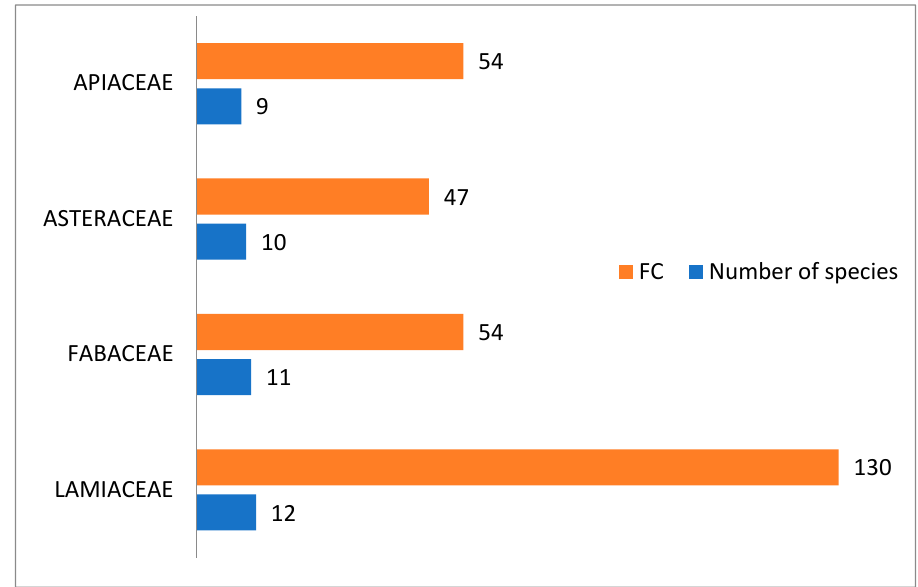
Figure 1. Most important families by frequency of citation and number of species.